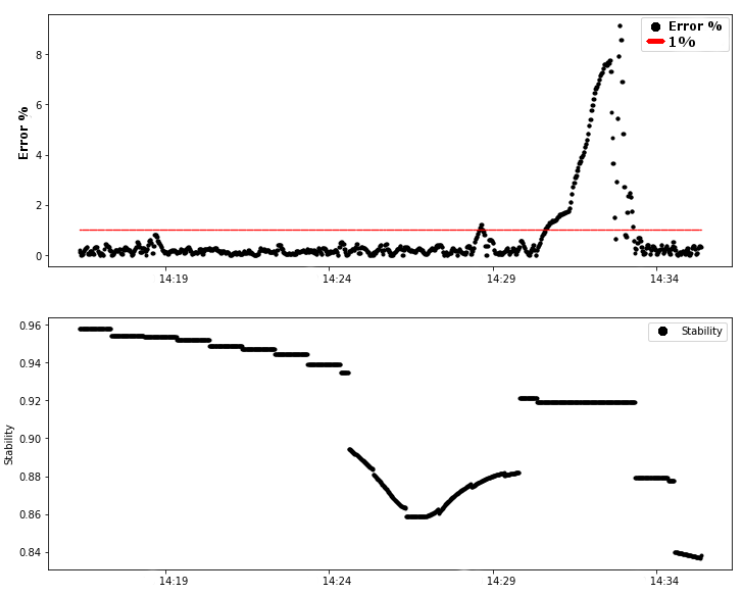
Figure 9. Test 01: Error (%) and Link0 stability.